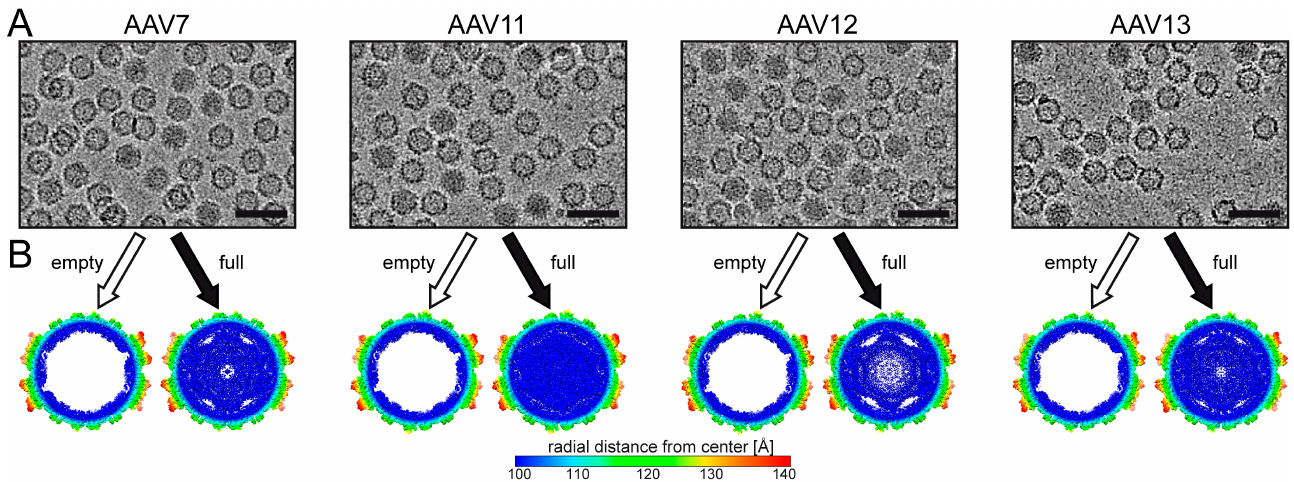
Figure 1. Cryo-electron microscopy (cryo-EM) reconstruction of genome containing (full) and empty AAV7 and AAV11– AAV13 capsids. ( A ) Cryo-electron micrographs showing the presence of full capsids (dark appearance) and empty (light appearance). Scale bar: 50 nm. ( B ) Cross-sectional views of the reconstructed maps determined by cryo-EM reconstruction from full and empty capsids contoured at a sigma ( σ ) threshold level of 0.9. The reconstructed maps are radially colored (blue to red) according to radial distance to the particle center. This figure was generated using UCSF-Chimera [48].